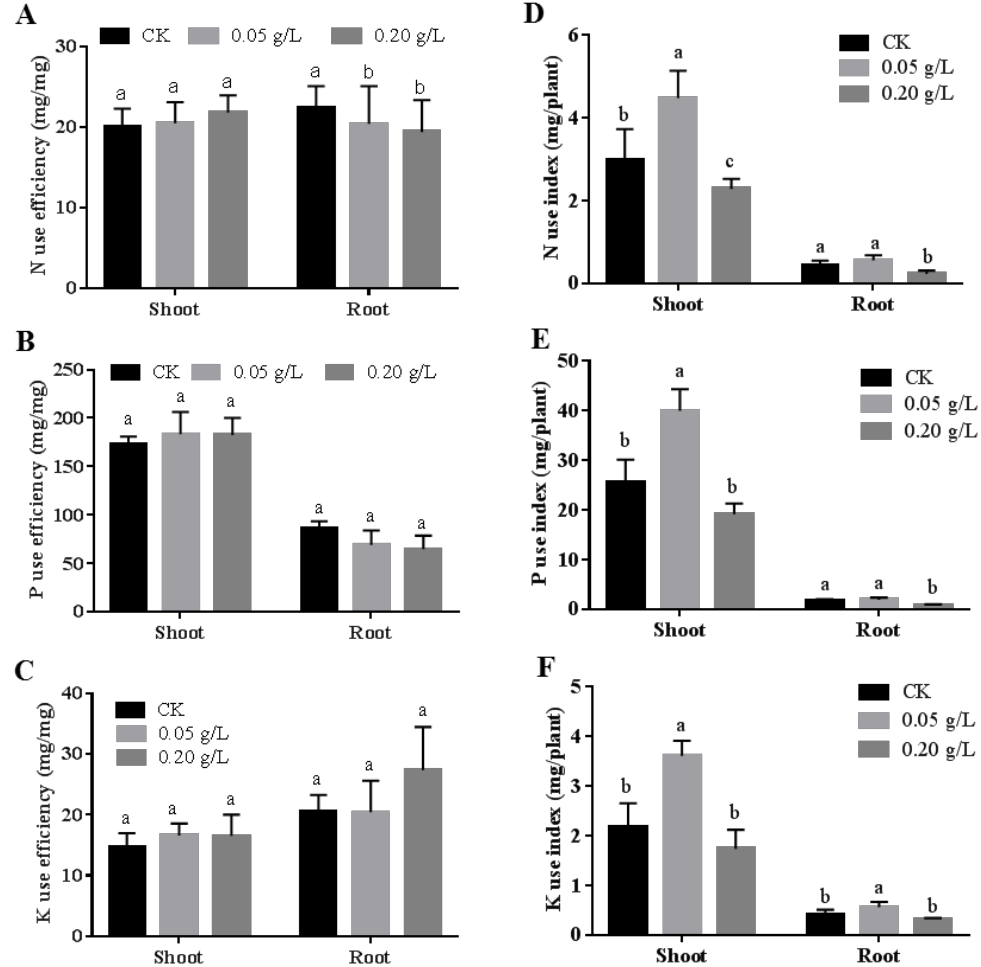
Figure 6. The use e ffi ciency and use index of nitrogen (N), phosphorus (P) and potassium (K) in Brassica Figure 6. The use efficiency and use index of nitrogen (N), phosphorus (P) and potassium (K) in napus under di ff erent CMS treatments. CK is a full-strength Hoagland’s solution. Two concentrations Brassica napus under different CMS treatments. CK is a full-strength Hoagland’s solution. Two (0.05 and 0.20 g L − 1 ) of CMS were added to the Hoagland’s solution. ( A ) N use e ffi ciency; ( B ) P concentrations (0.05 and 0.20 g L −1 ) of CMS were added to the Hoagland’s solution. ( A ) N use use e ffi ciency; ( C ) K use e ffi ciency; ( D ) N use index; ( E ) P use index; ( F ) K use e ffi ciency. Di ff erent efficiency; ( B ) P use efficiency; ( C ) K use efficiency; ( D ) N use index; ( E ) P use index; ( F ) K use letters indicate the significant di ff erences at p < 0.05 by Duncan’s test. Data are means ± SD with six efficiency. Different letters indicate the significant differences at P < 0.05 by Duncan’s test. Data are biological means ± SD with six biological replicates.